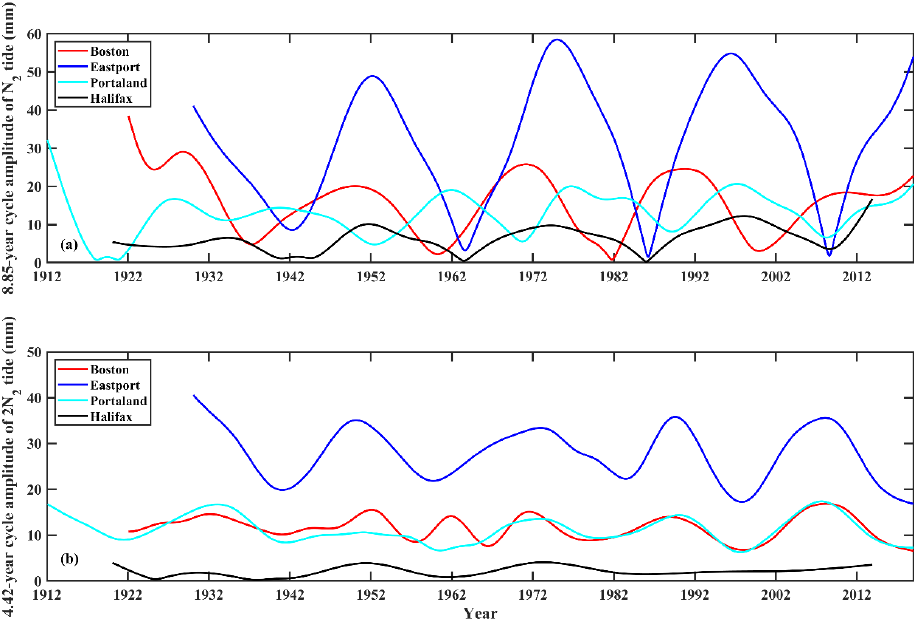
Figure 6. The 8.85-year cycle amplitudes of N 2 tide ( a ) and 4.42-year cycle amplitudes of 2N 2 tide ( b ) at Boston, Eastport, Portland, and Halifax.